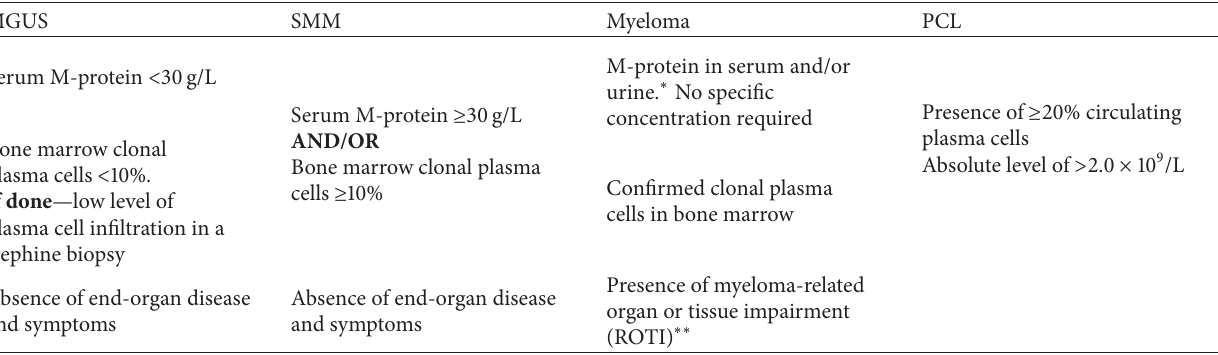
Table 1: Diagnostic criteria for myeloma of undetermined significance (MGUS), smouldering multiple myeloma (SMM), myeloma, and plasma cell leukemia (PCL). Reproduced from international myeloma working group, 2003 [37].